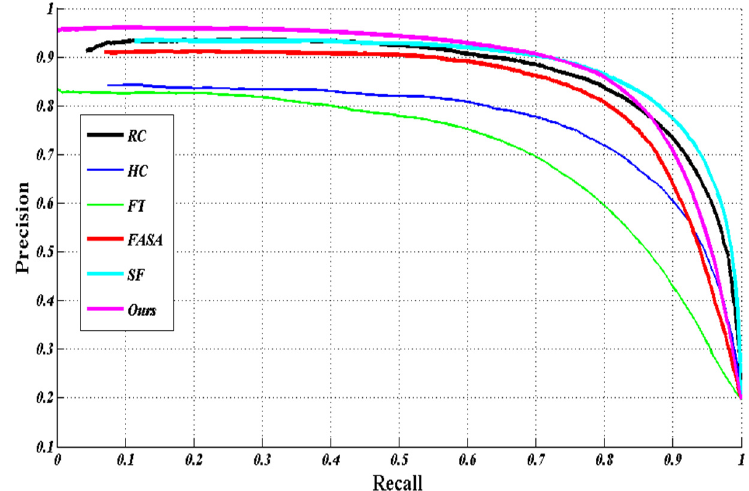
Figure 10. Precision-recall curves of our method compared with the other five